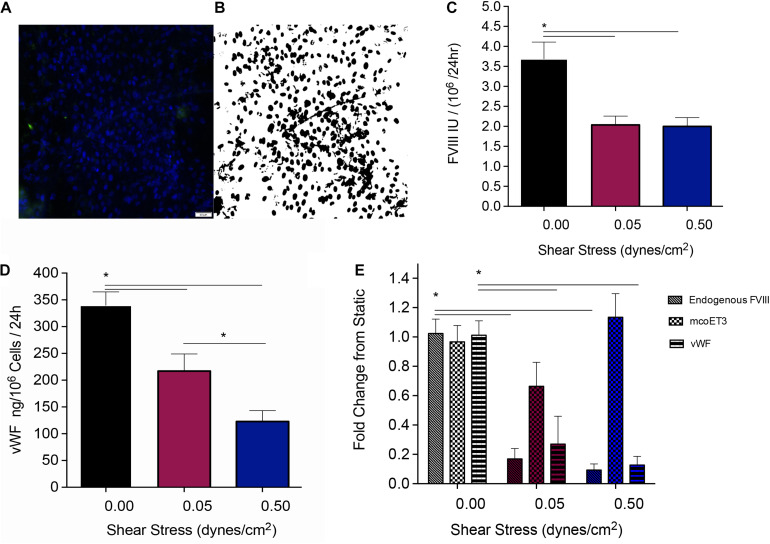
Quantification of the protein production and secretion from PLC-mcoET3 under conditions of shear stress. (A) Representative image of cell quantification: In order to quantify the number of cells in the devices, they were first stained with DAPI, and then (B) a black and white threshold was applied before a particle analysis was performed in ImageJ to count cells in representative areas. This count was scaled to the full area of the device channel and used to normalize our data to cell count. (C) fVIII/mcoET3 activity in PLC-mcoET3 supernatants was significantly reduced in conditions under flow when compared to static conditions (static conditions n = 15; 0.05 dyne/cm2
n = 11; and 0.5 dyne/cm2
n = 10) (p < 0.05). No difference in fVIII/mco-ET3 activity was found between shear stress conditions of 0.05 dyne/cm2 and 0.5 dyne/cm2. (D) ELISA was used to measure the vWF protein concentration in the supernatant (static conditions n = 15; 0.05 dyne/cm2
n = 9; 0.5 dyne/cm2
n = 8). vWF concentration in supernatants from PLC-mcoET3 under shear rates of 0.05 dyne/cm2 were significantly decreased when compared to those of under static conditions (p < 0.05). At the higher shear rate of 0.5 dyne/cm2, vWF concentration was significantly decreased when compared to both 0.05 dyne/cm2 (p < 0.05) and to static conditions (p < 0.05). (E) RNA expression of these proteins was examined with RT-qPCR performed in triplicate (endogenous FVIII n = 6; mcoET3 n = 5; and vWF n = 3). Endogenous/constitutive expression of both FVIII and vWF mRNA was decreased significantly at both shear rates (p < 0.05). However, mcoET3 mRNA expression was not affected by conditions of flow. *p < 0.05.